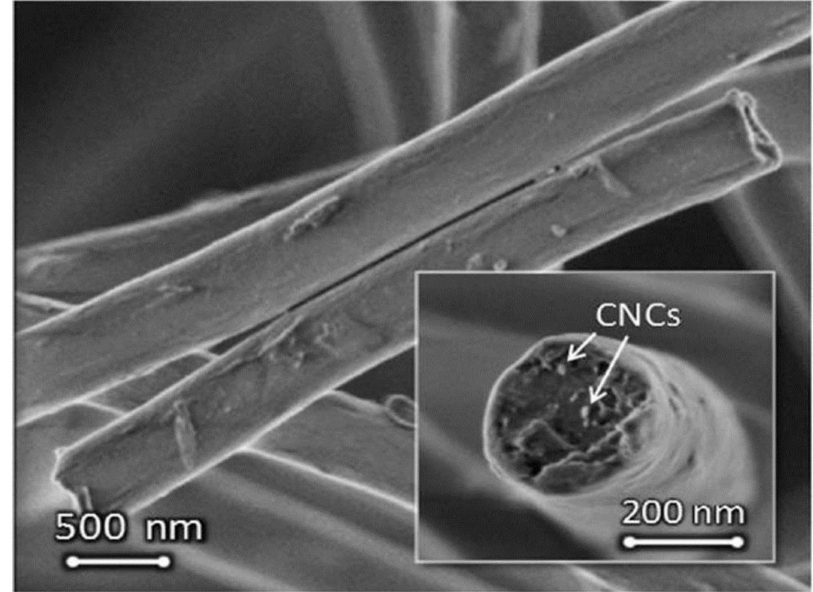
Figure 13. SEM images of lignin/polyvinyl alcohol (PVA)/cellulose nanocrytals (CNC) composite nanofiber, with an inset image of the cross-section of the said composite prepared by the freeze crack method [195]. Reproduced with permission from ref. [195]. Copyright American Chemical Society,